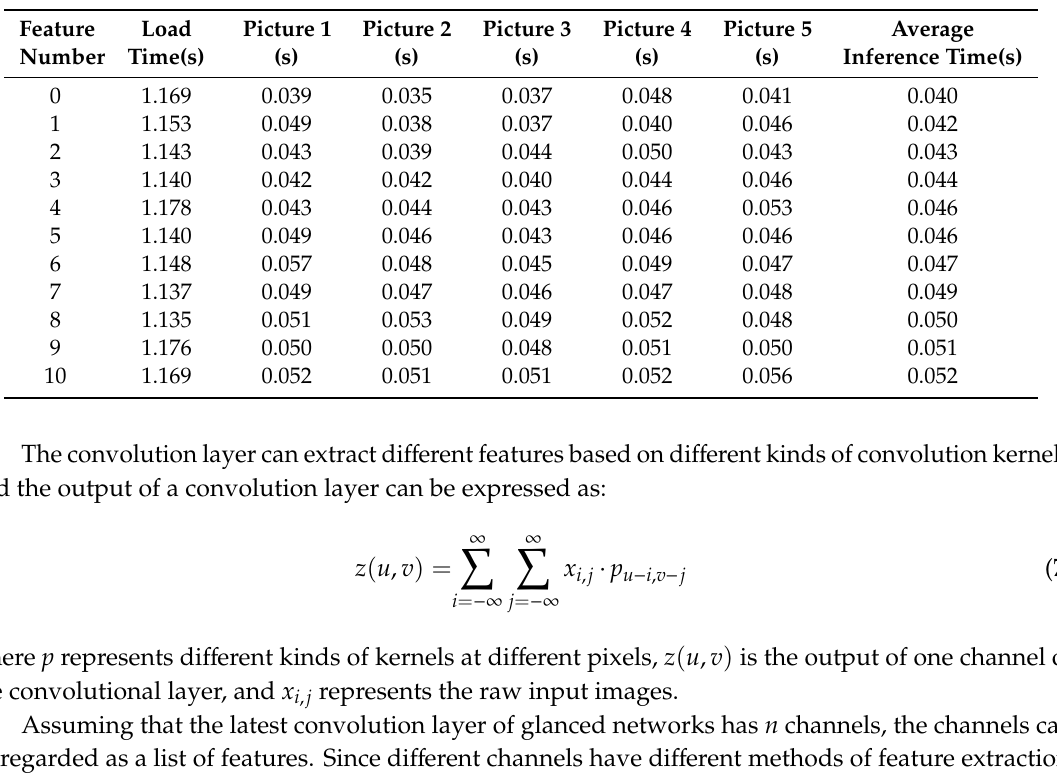
Table 2. Comparison results for di ff erent numbers of